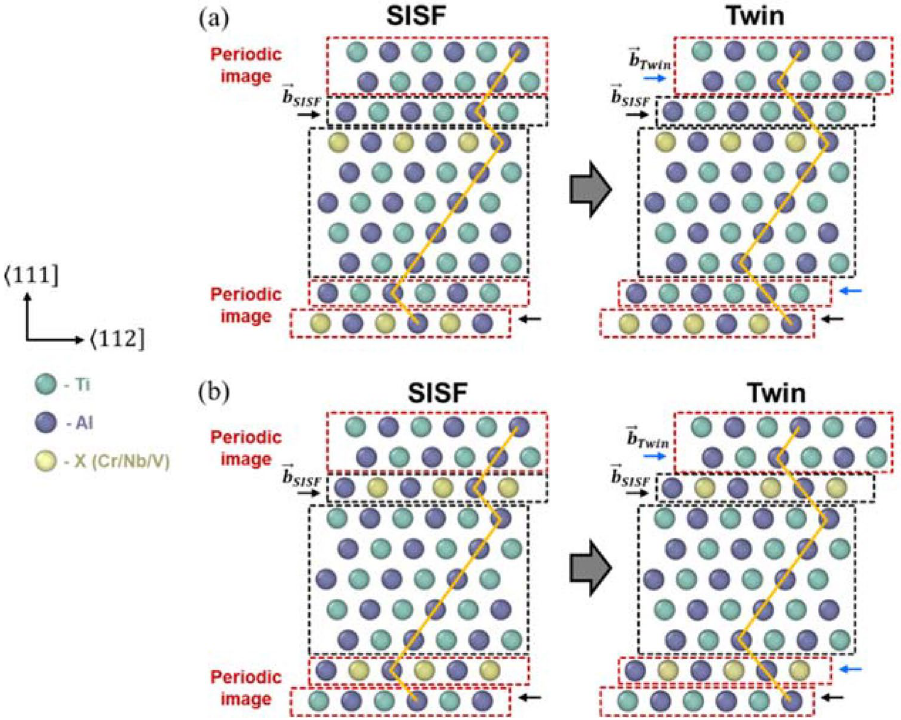
Figure 5. Two possible models for twinning: (a) the ternary alloying element X (Cr, Nb, or V) is located in a single slip plane and (b) the ternary alloying element X is located between both slip planes.